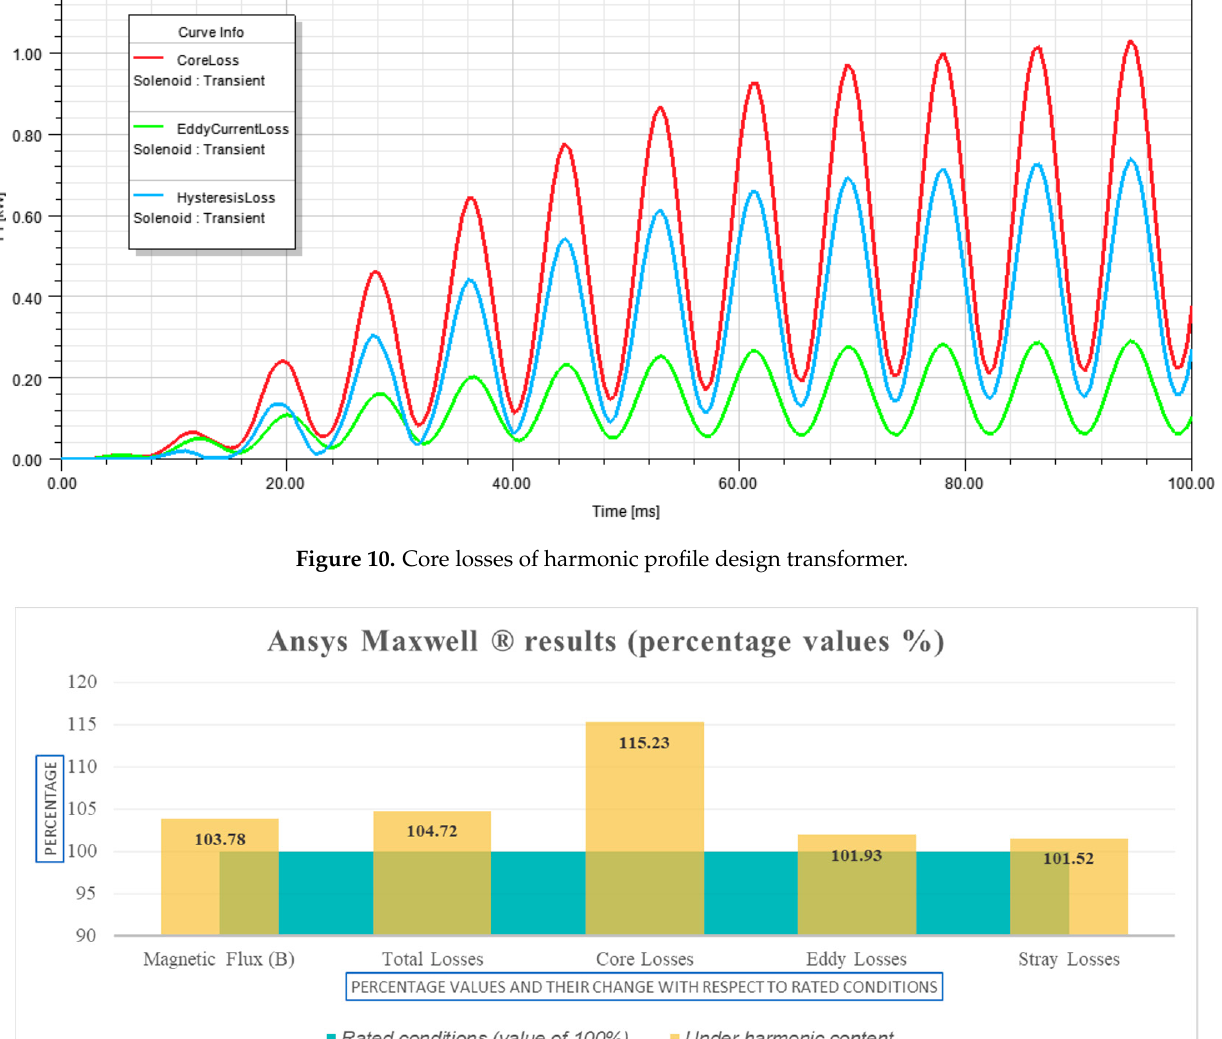
Figure 11. Ansys Maxwell ® percentage changes in main design parameters between transformer standard design and harmonic profile design.